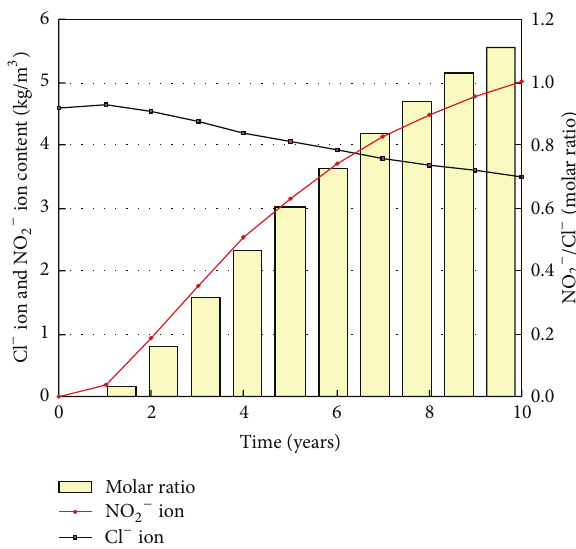
Figure 18: Changes in Cl − and NO 2− ion content, NO 2− /Cl − molar ratio with time at a depth of 85 mm (the position of inner steel bars).